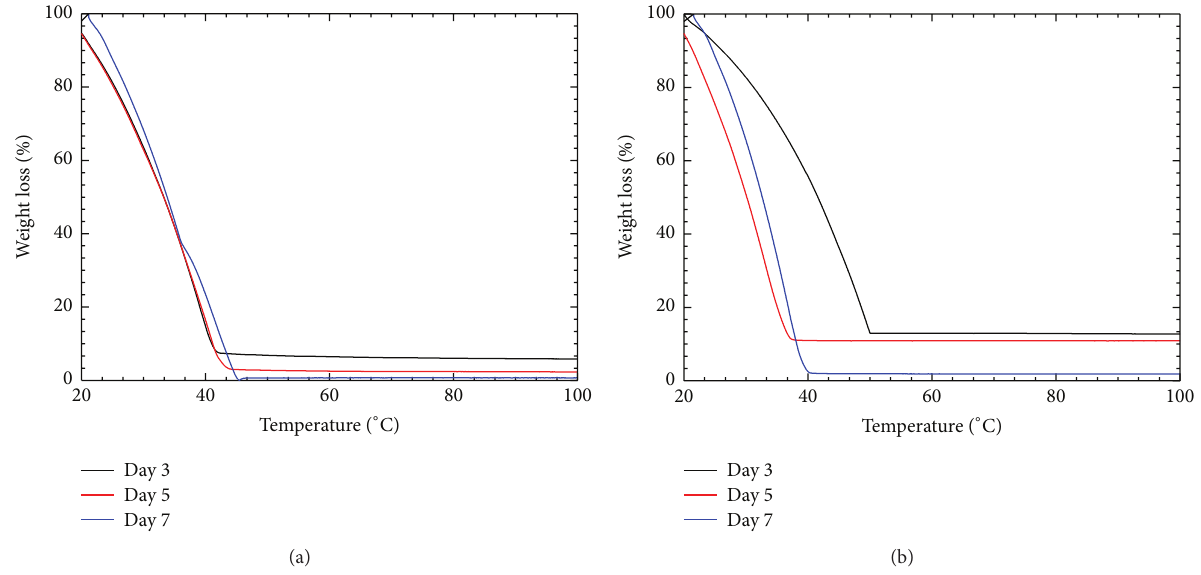
Figure 9: The water holding capacity calculated for the (a) control and (b) RMF exposed BC